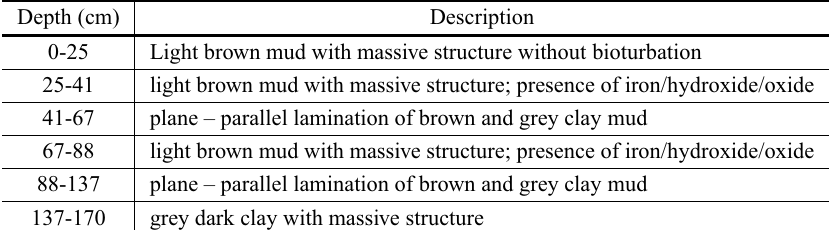
Stratigraphic description of the Lagoa Grande core.